Question: What form of chart is displayed?
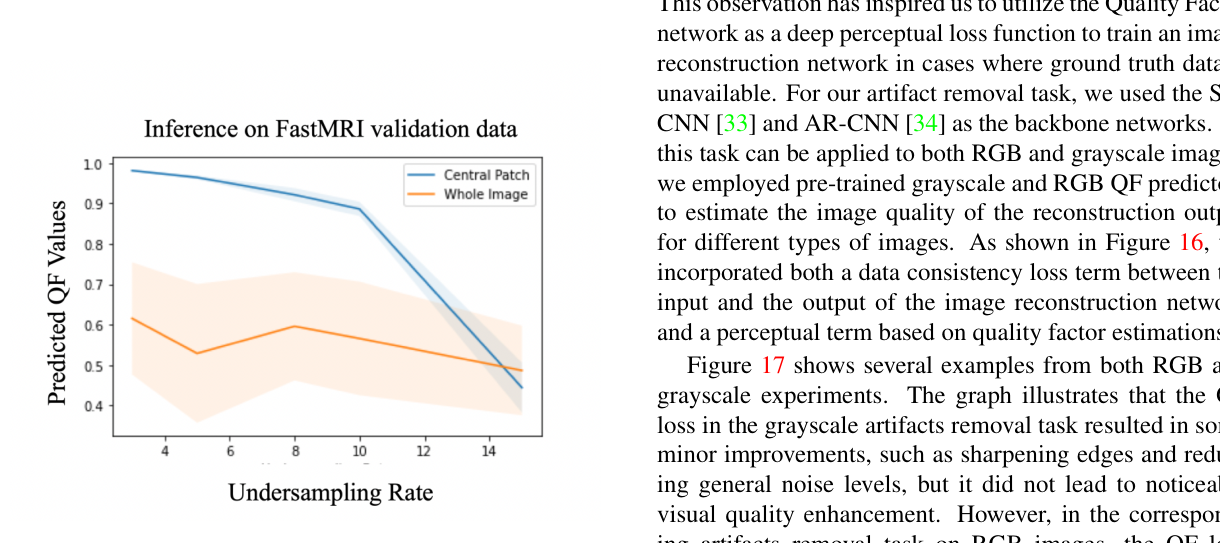
Answer: line